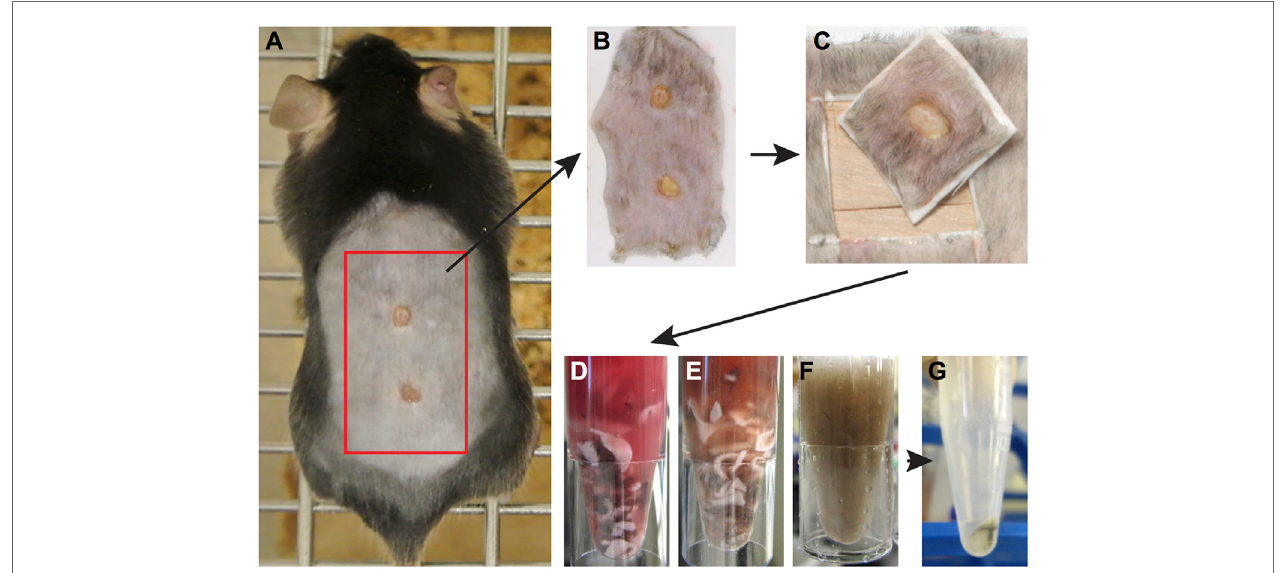
FIgURe 4 | Enzymatic tissue digestion. (A) Whole-body photograph of wounded mouse just prior to sacrifice. (B) Skin tissue removed from sacrificed animal and placed on white filter paper to prevent folding of tissue. (C) 1 cm 2 piece of skin containing the wound and surrounding tissue. Note wound should be centered within the isolated tissue. (d–F) Tissue cut into small pieces with a scalpel placed in a 1.5-mL Eppendorf tube containing an enzyme digestion cocktail. Tissue digestion takes place at 37° for 2 h and images show tissue digestion at the start (d) , midway through digestion, (e) and at the completion of digestion (F) . (g) Following digestion, the solution is filtered to remove tissue debris and remaining cells are pelleted by centrifugation. Cells are now ready for analysis by flow